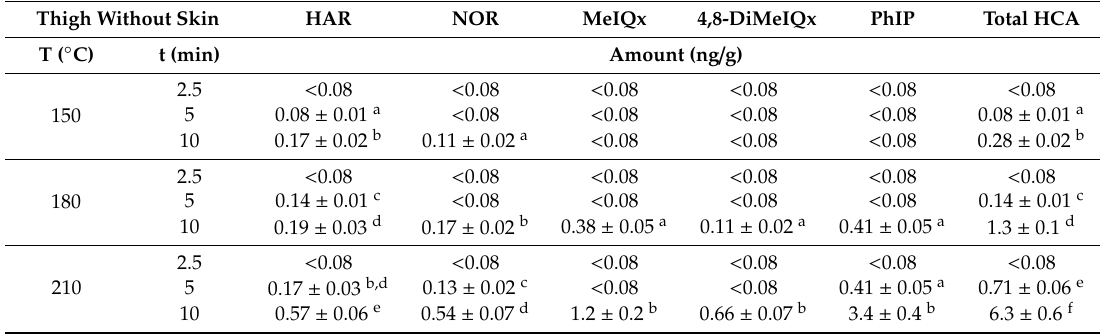
Table 4. Heterocyclic amine (HCA) content of heat-treated chicken thigh without skin and bones.